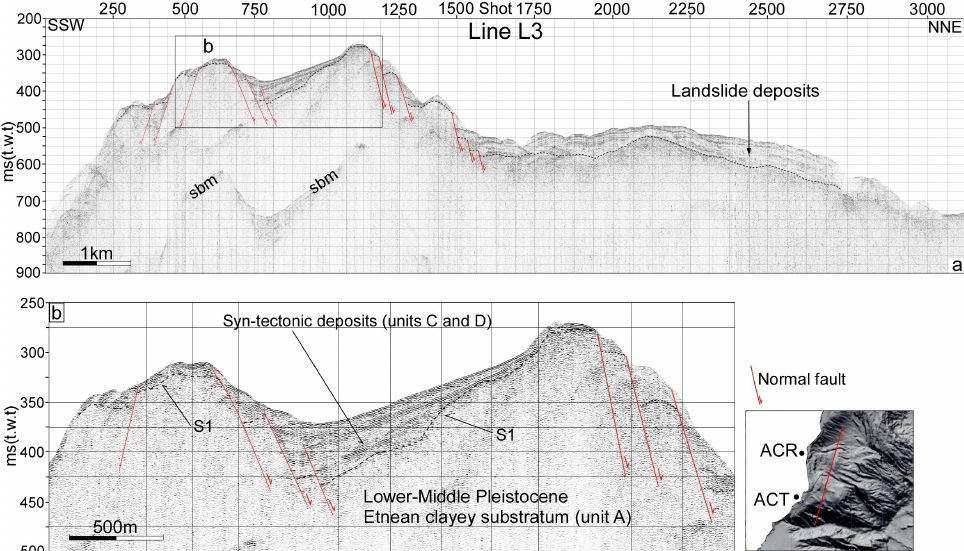
Figure 5. ( a ) interpreted line L3 showing a set of normal faults controlling the seafloor morphology (see Figure 1b for location); ( b ) Recent sediments within the wedge-shaped basin suggest syn-sedimentary activity on these faults ACR: Acireale; ACT: Aci Trezza; S1: erosional surface; sbm: sea bottom multiple.